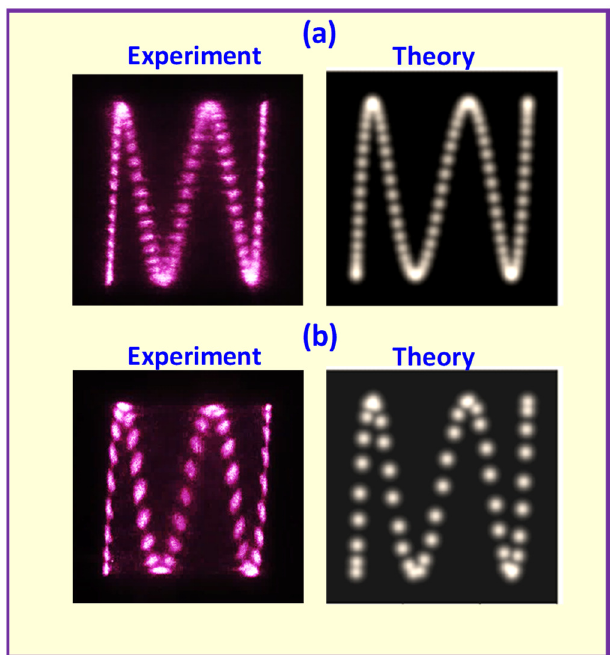
Figure 14. Similar to Figure 13 for the two cases of ( a ) 𝑀 = 46 and ( b ) 𝑀 = 47 with the parameters of (𝑃, 𝑄) = (1, 4) , (𝑝,𝑞) = (5,−1) , (cid:3435)𝑁 (cid:3051) , 𝑁 (cid:3052) (cid:3439) = (300, 300) , 𝜙 (cid:3051) = 𝜙 (cid:3052) = 0, 𝑚 = 1 .